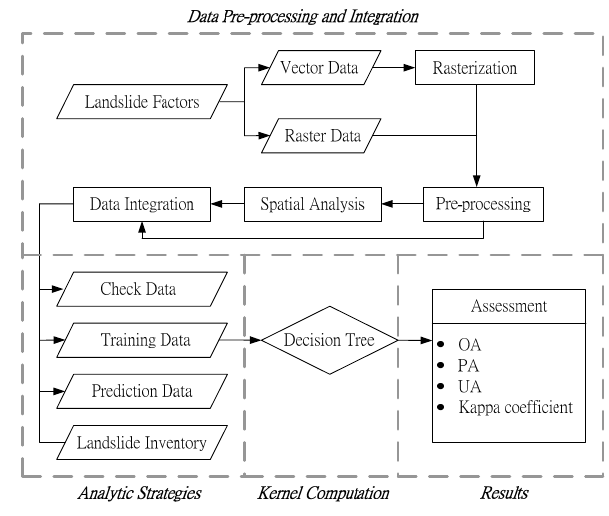
Figure 2. The procedure of this